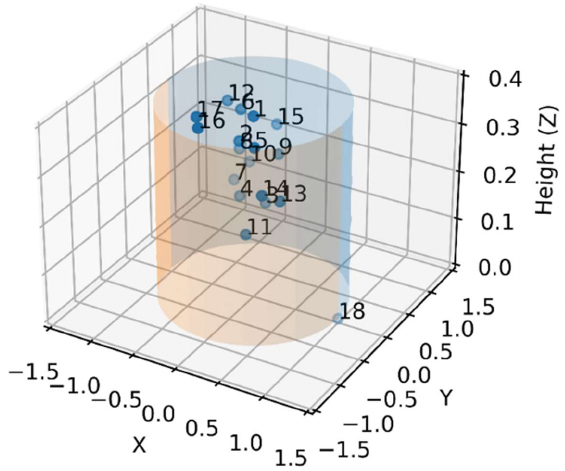
Figure 13. Position of the calculated bubbles using the PPM developed in this study. Calculation 1 at 60 SCFM. Table 4. Identification number for each bubble reported in Figure 13, along with size and velocity of each bubble. Bubble